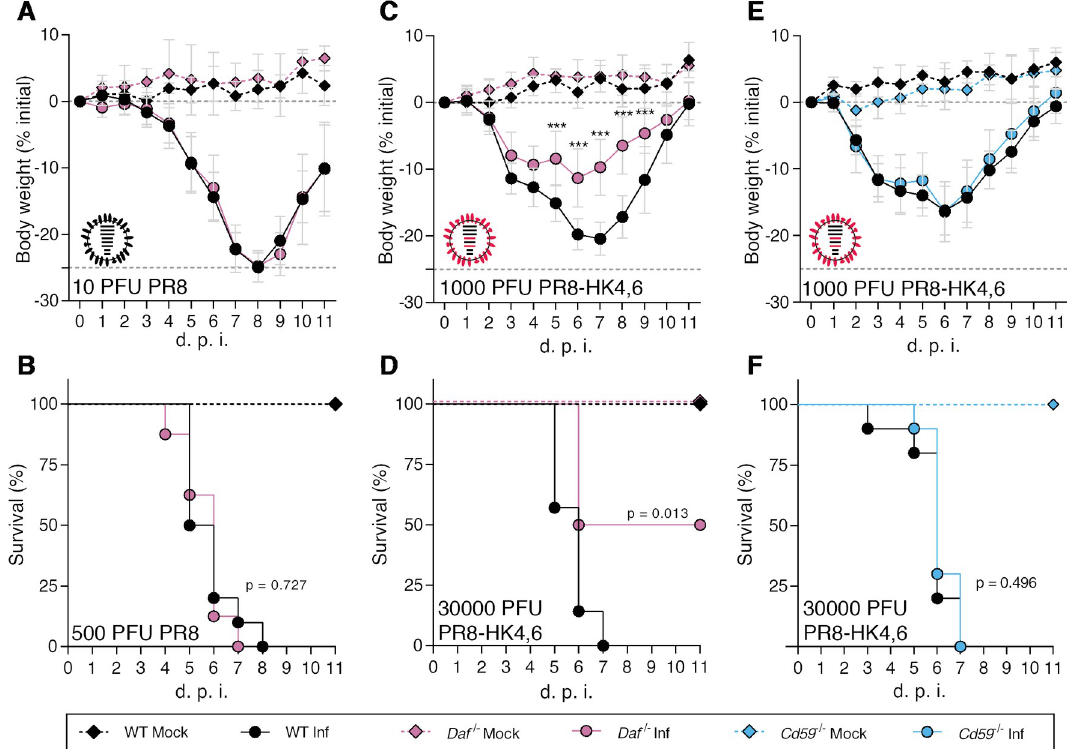
Fig 2. Daf -/- mice are protected against PR8-HK4,6, but not PR8, and protection is specific of this RCA. A, B : Bodyweight loss ( A ) and mortality ( B ) of C57BL/6J WT or Daf -/- mice infected with the indicated doses of A/Puerto Rico/8/1934 (PR8) ( A : Inf n = 8 per group; mock n = 7 and n = 4 for WT and Daf -/- respectively; B : Inf n = 9 and n = 10, mock n = 8 and n = 4 for WT and Daf -/- respectively). C, D : Bodyweight loss ( C ) and mortality ( D ) of C57BL/6J WT or Daf -/- mice infected with the indicated doses of A/X-31 (PR8-HK4,6) ( C: Inf n = 9 and n = 10, mock n = 8 and n = 4 for WT and Daf -/- respectively; D: Inf n = 7 and n = 8, mock n = 3 and n = 2 for WT and Daf -/- respectively). E, F : Bodyweight loss ( E ) and mortality ( F ) of C57BL/6J WT or Cd59 -/- mice infected with the indicated doses of PR8-HK4,6 ( E: Inf n = 10 and n = 11 for WT and Cd59 -/- respectively, mock = 7 per group; F : Inf n = 10 per group, mock n = 4 and n = 7 for WT and Cd59 -/- respectively). Results are expressed as mean ± sd, statistical analysis detailed in materials and